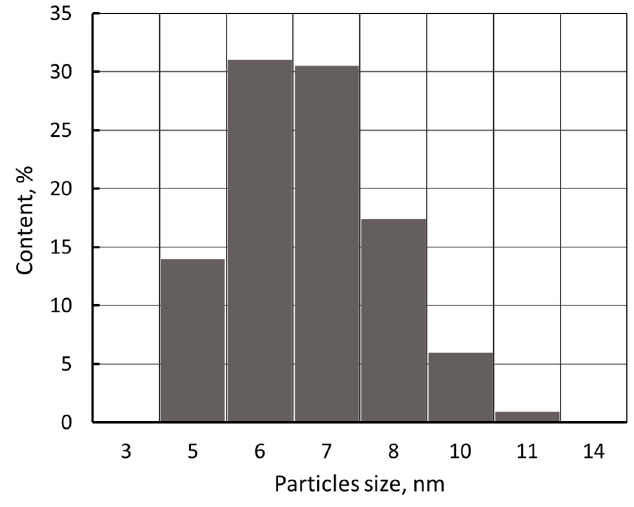
Figure 1. The particle size distribution of sodium in nanosuspension.